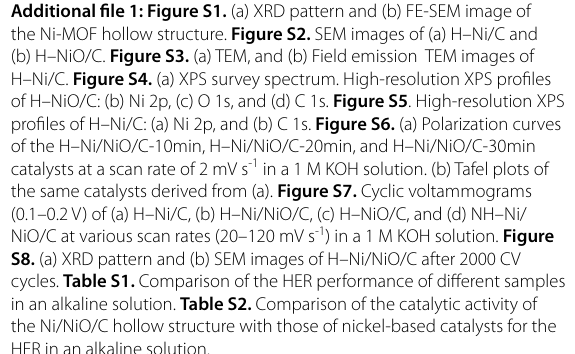
cycles. Table S1. Comparison of the HER performance of different samples in an alkaline solution. Table S2. Comparison of the catalytic activity of